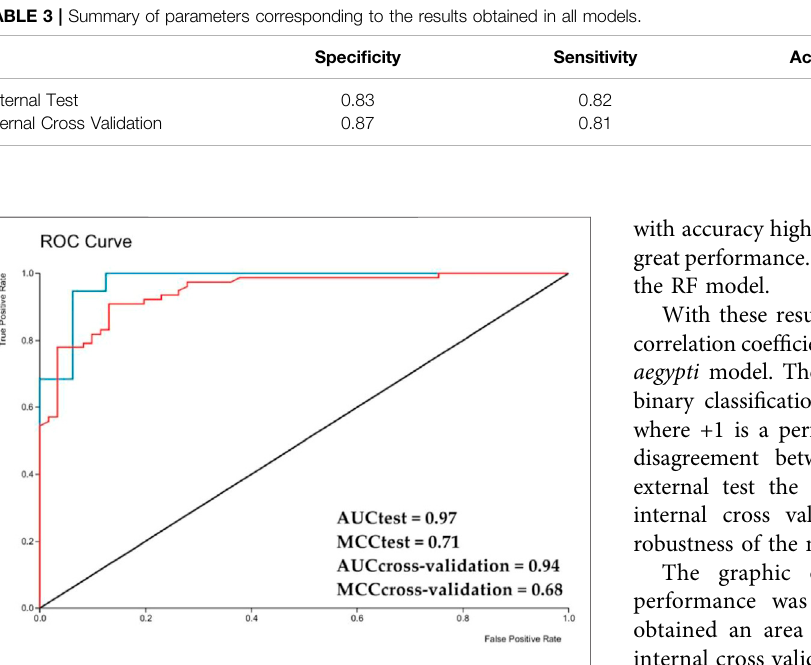
FIGURE 2 | ROC chart with area under a curve for the Aedes aegypti modeltestsetobtainedwithRandomForest.AUC — areaunderthecurve;red line — Internal cross validation; blue line — External test.